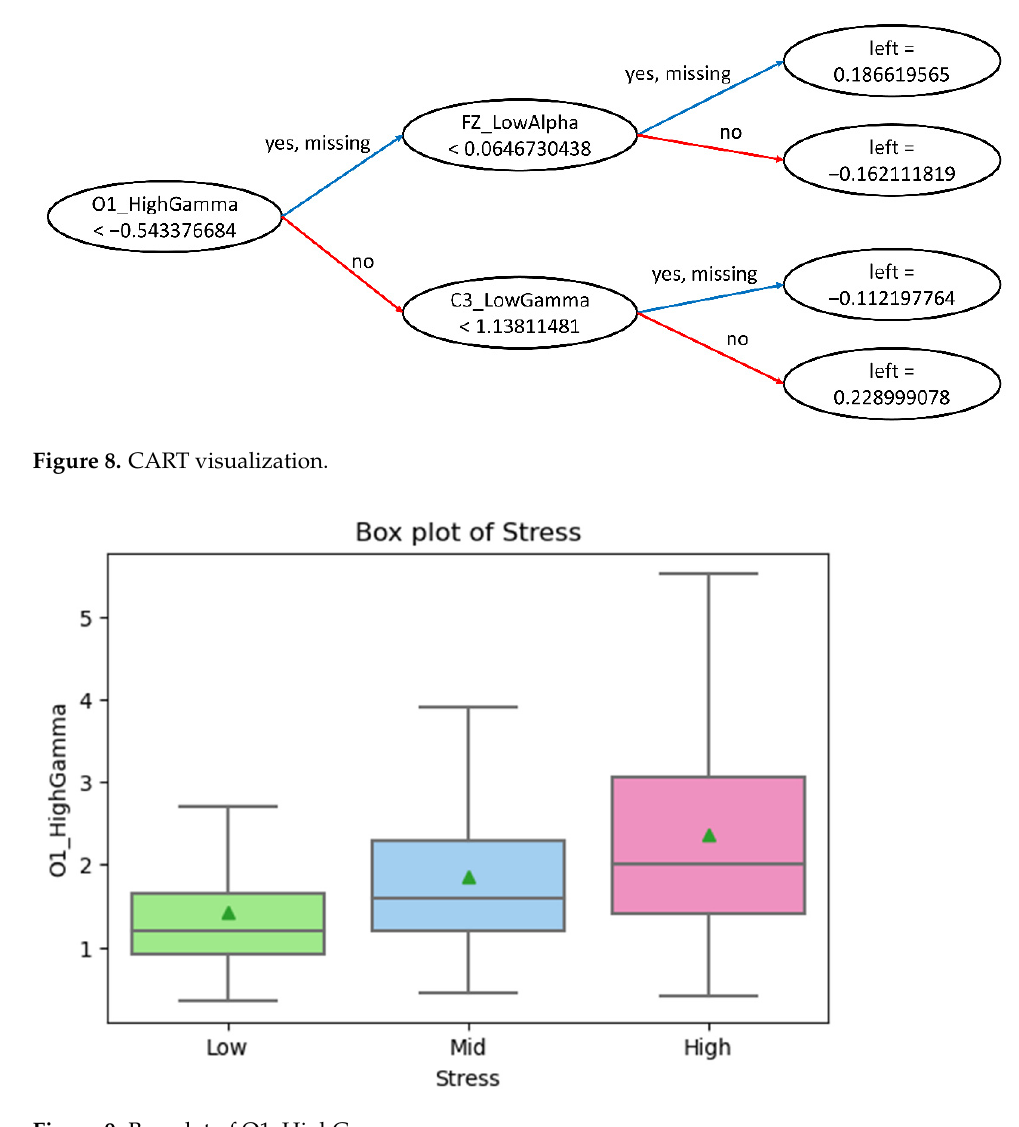
Figure 9. Box plot of O1_HighGamma.